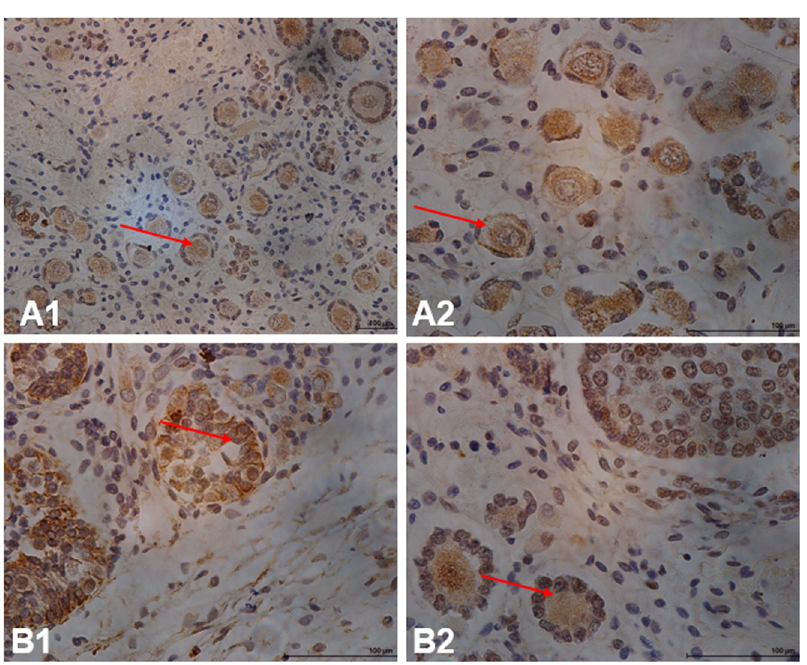
Fig 4. Immunostaining results for FAM9B expression in human ovarian sections. In ovary cells, FAM9B was localized in the nucleus and cytoplasm. FAM9B is clearly present in ovarian sections (4A). FAM9B is distributed in adult ovaries (red arrow) and localized in granulosa cells (Fig 4B). FAM9B is also evident in follicle cell nucleus and diffusely dispersed in granular cell cytoplasm (red arrow). Bars = 10 μ m.